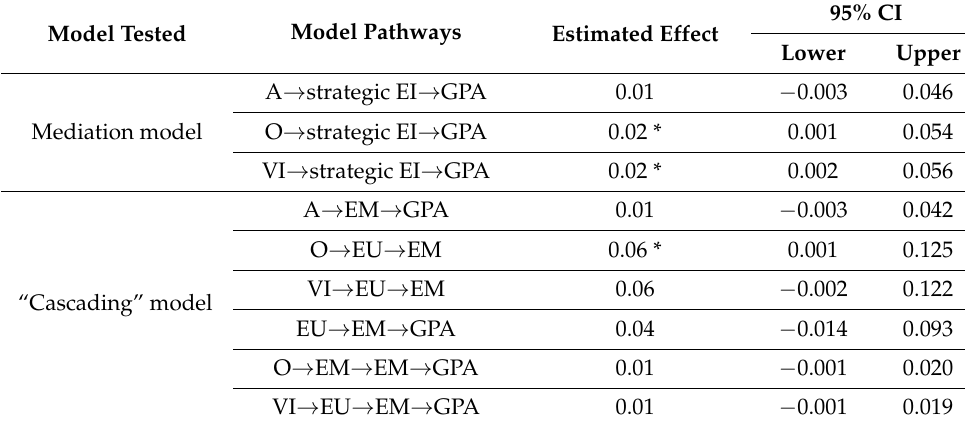
Table 2. Standardized indirect effects and 95% confidence intervals for the mediation and “cascading” models. Model